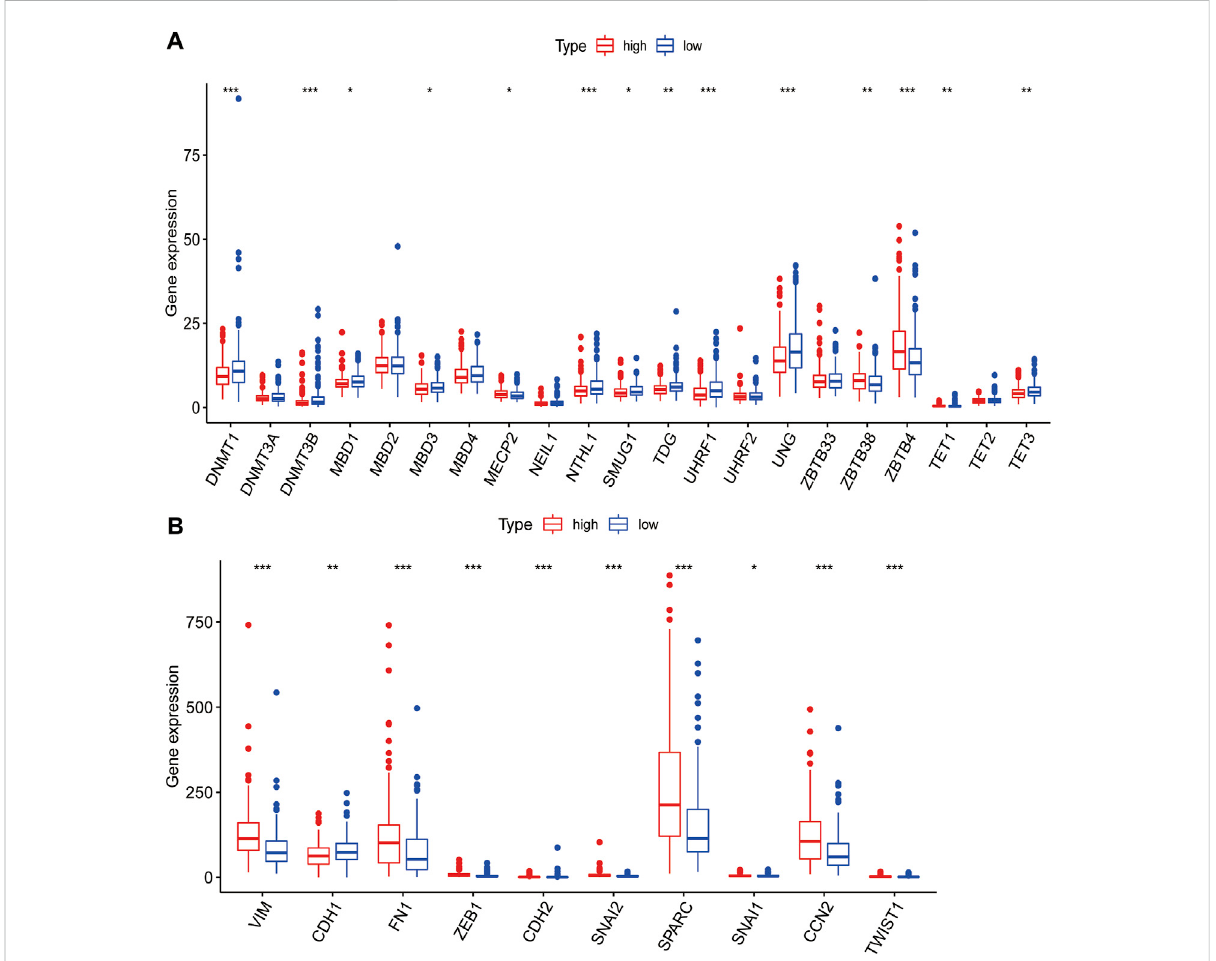
FIGURE 7 Correlation analysis of PLT-related lncRNAs with methylation and EMT. (A) Differences of 5mC Regulator expression between patients in the high- and low-risk groups. (B) Differences of EMT-related gene expression levels among high- and low-risk